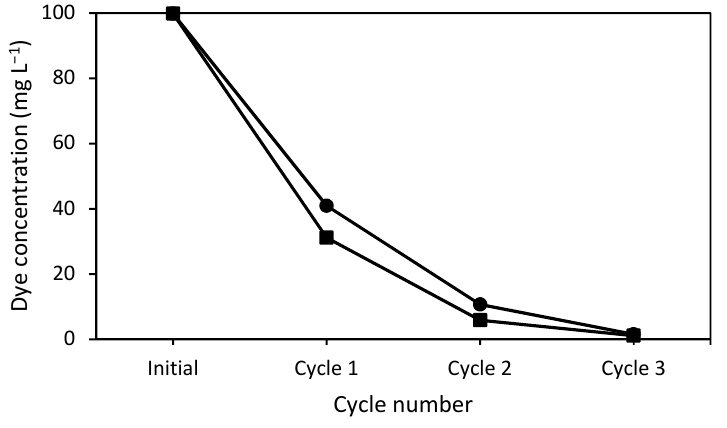
Figure 4. Variation of AV43 concentration using T:D (1:1), ( (cid:4) ) and T:C (2:1), ( • ).